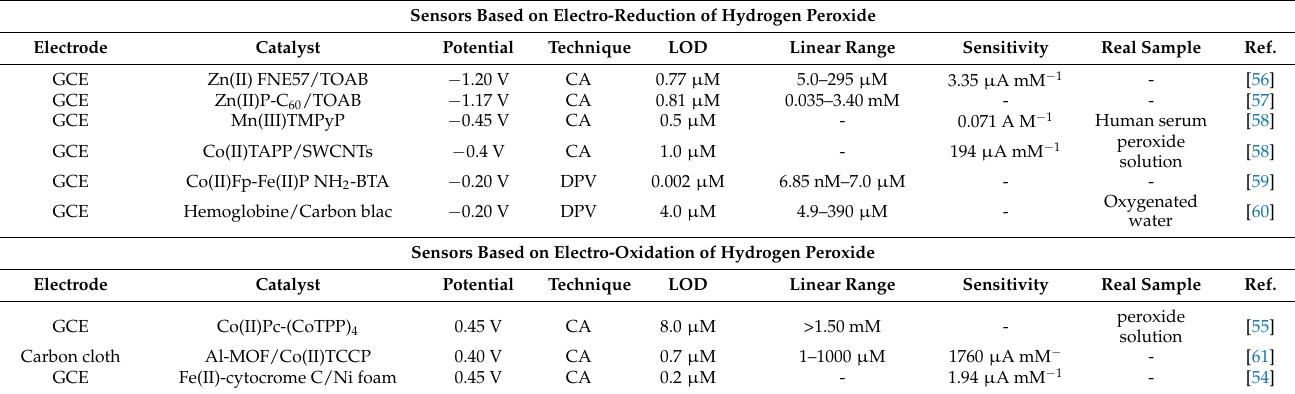
Table 6. Examples of non-enzymatic H 2 O 2 sensors based on MP and MPc complexes. Sensors Based on Electro-Reduction of Hydrogen